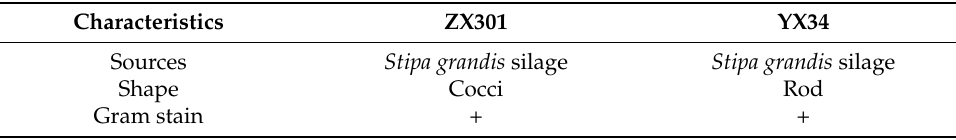
Table 1. The selection of isolated lactic acid bacteria on the base of the morphological and physiologi- cal